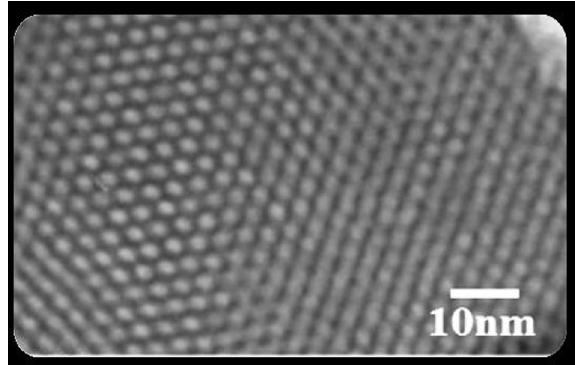
Figure 3. Hexagonal configureuration (TEM) of LUS-1